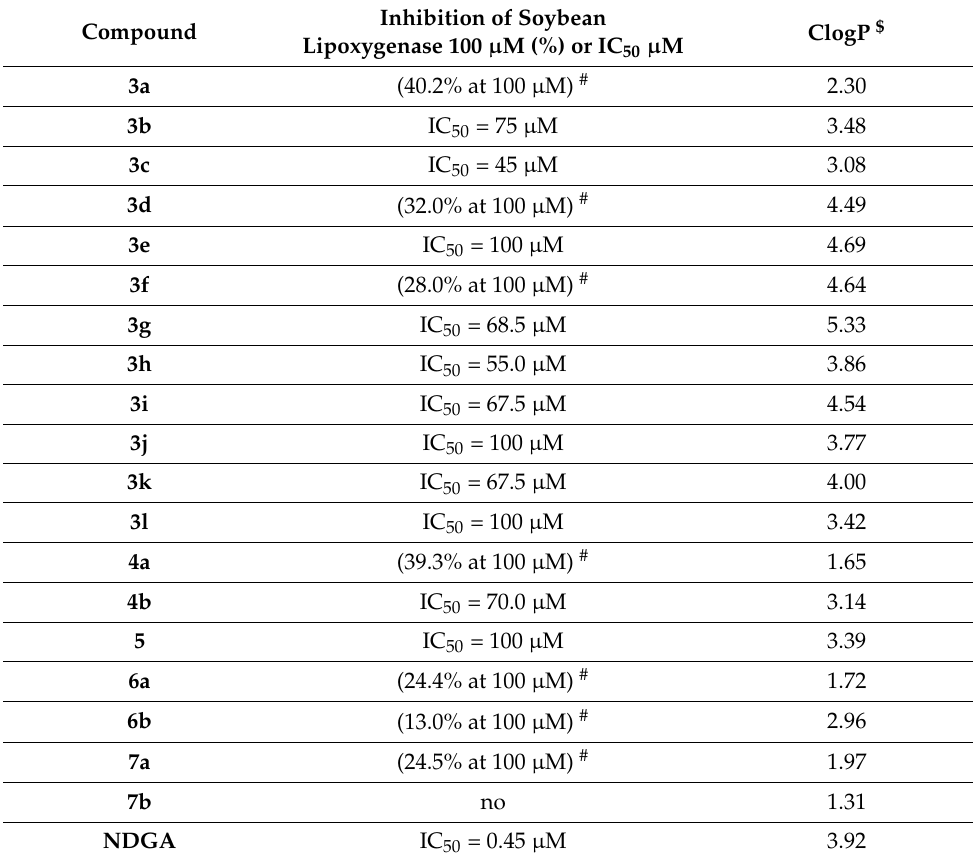
Table 5. In vitro determination of soybean inhibition; theoretically calculated lipophilicity as ClogP